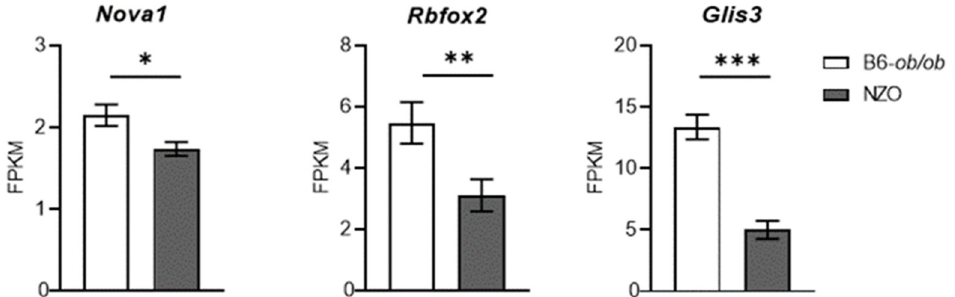
Figure 4. Differential expression of neuron specific splicing factors and the diabetes gene Glis3 . Expression of Nova1 , Rbfox2 , and Glis3 of islets from B6-ob/ob and NZO mice was detected by RNAseq. * p < 0.05; ** p < 0.01; *** p < 0.001.